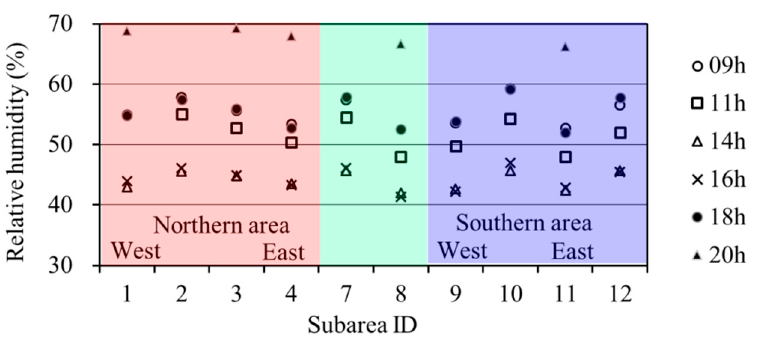
Figure 9. Horizontal distribution of relative humidity on 31 August 2010. ( a ) 1400 LST, ( b ) 1800 LST.